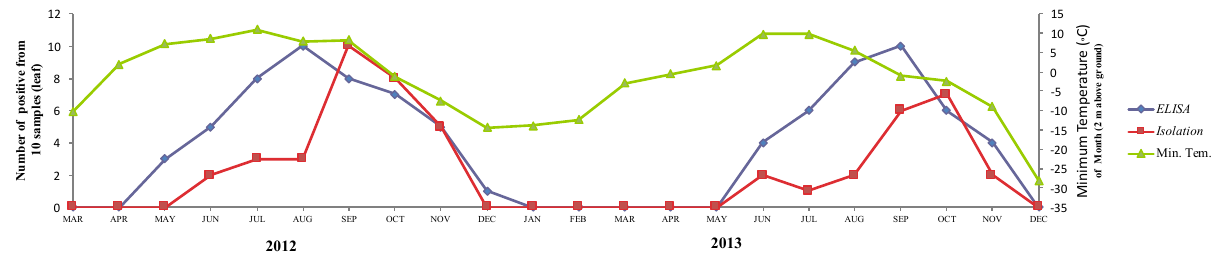
Figure 1. Detection of Xylella fastidiosa in leaves and shoots of almond trees in orchards during 2012-13.